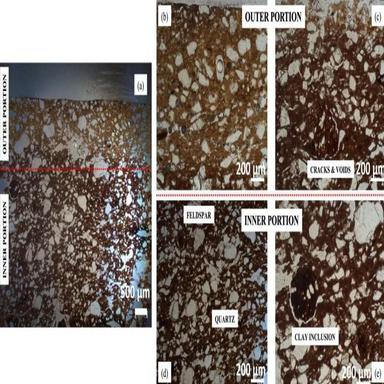
Optical micrographs of ARA13-2: (a) panoramic view of the ancient ceramic where the two different portions can be well distinguished (N//), (b and c) outer portion of the ceramic characterised by mineral inclusions, mainly quartz and feldspar (b), and isooriented cracks and voids (c) (N//); (d and e) inner portion of the ceramic characterised by well-graded mineral (quartz and feldspar) (d) and well rounded clay-rich inclusions (e) (N//).